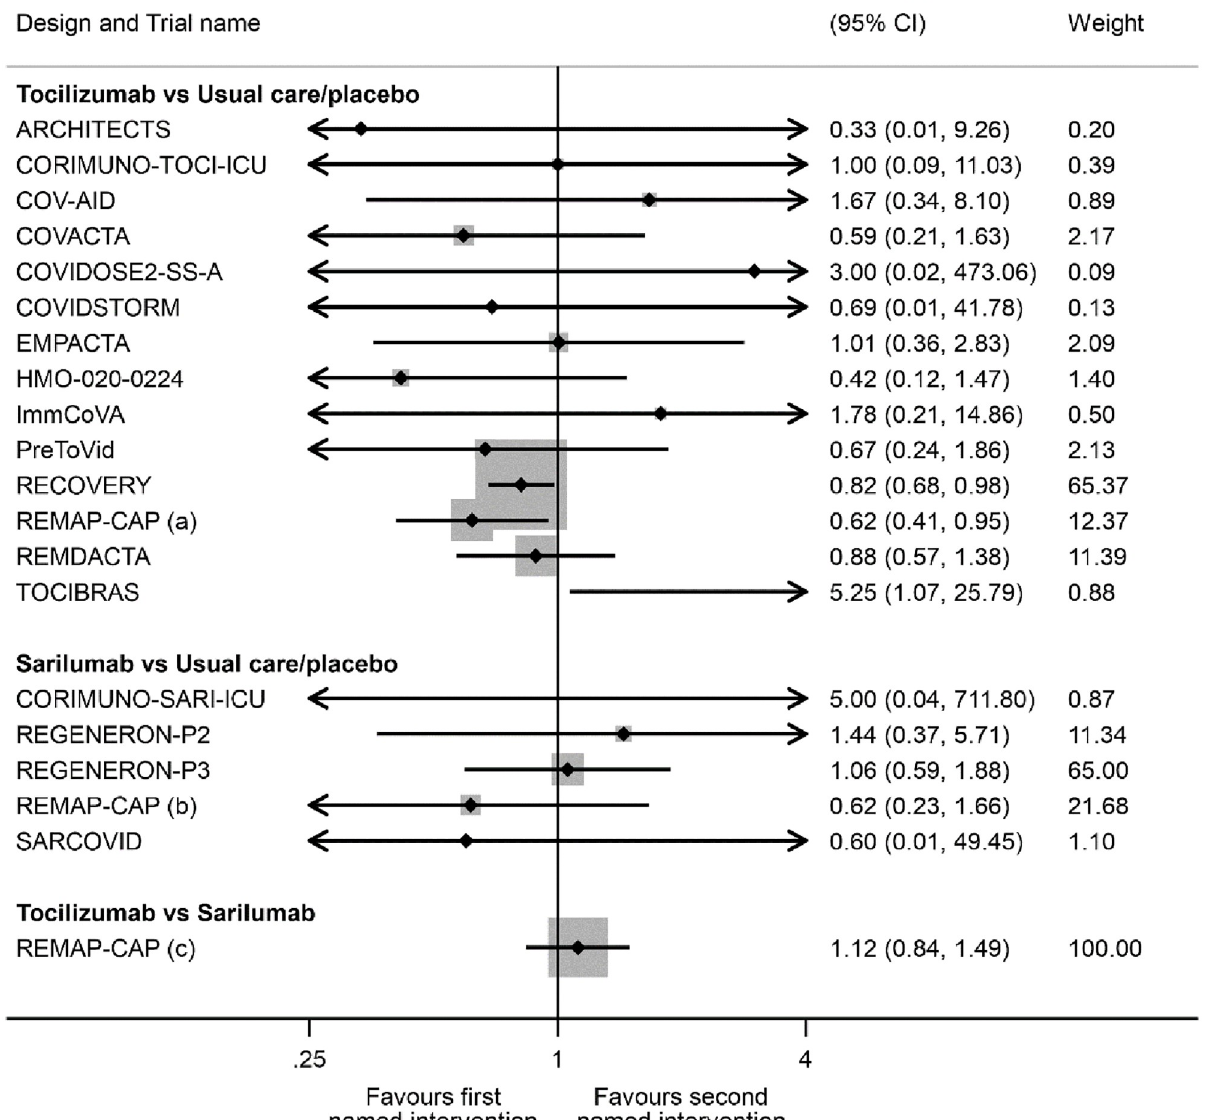
PLOS ONE | https://doi.org/10.1371/journal.pone.0270668 July 8,